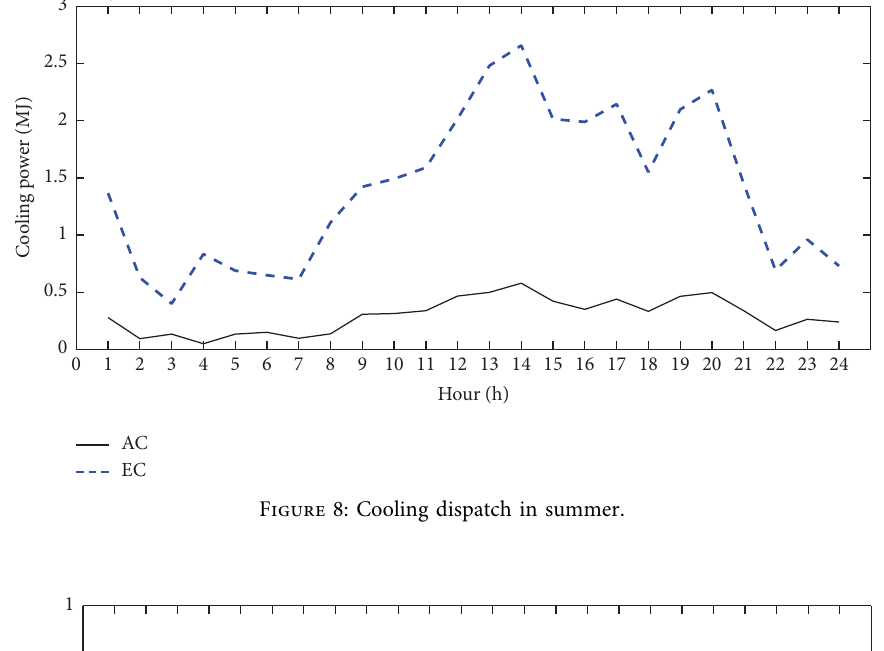
Figure 8: Cooling dispatch in summer.